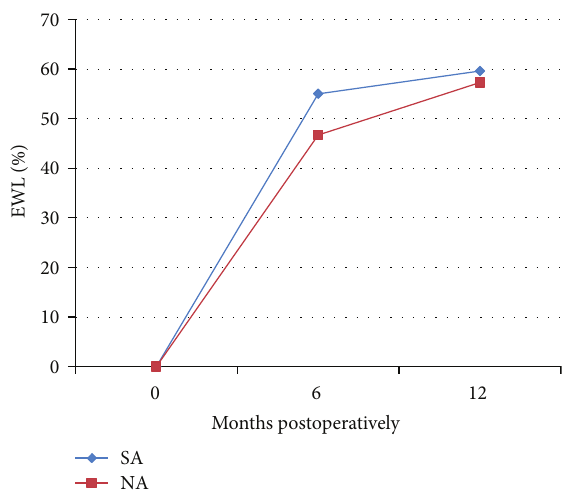
Figure 2: Percent excess weight loss (%EWL) in each group, after sleeve gastrectomy (LSG). SA: substance abuse cohort; NA: no substance abuse